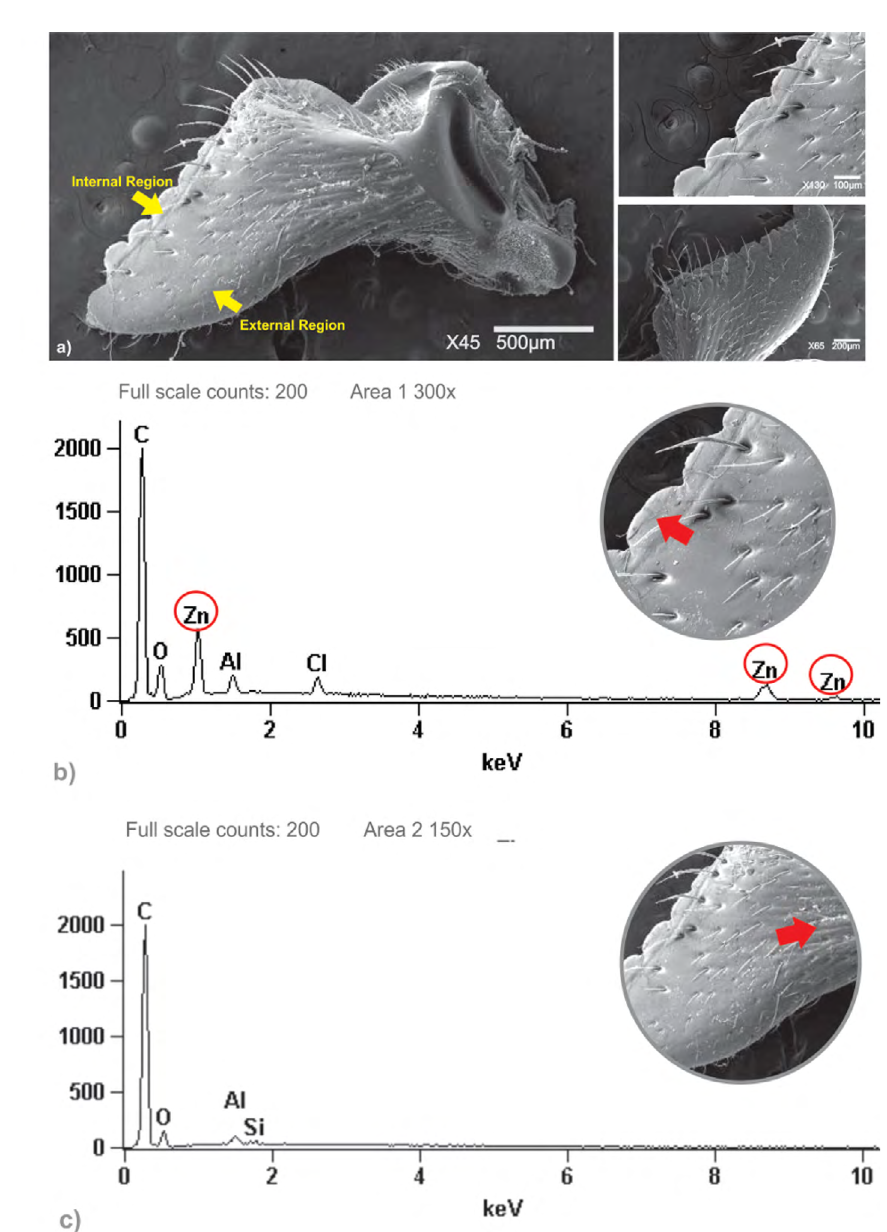
Figure 5. (a) SEM of the mandible Atta laevigata identifying morphological details of the internal and external regions; (b) representative analysis via EDS on the surface of the mandible, identifying metallic elements such as zinc in the internal region, (c) absence of Zn in the external